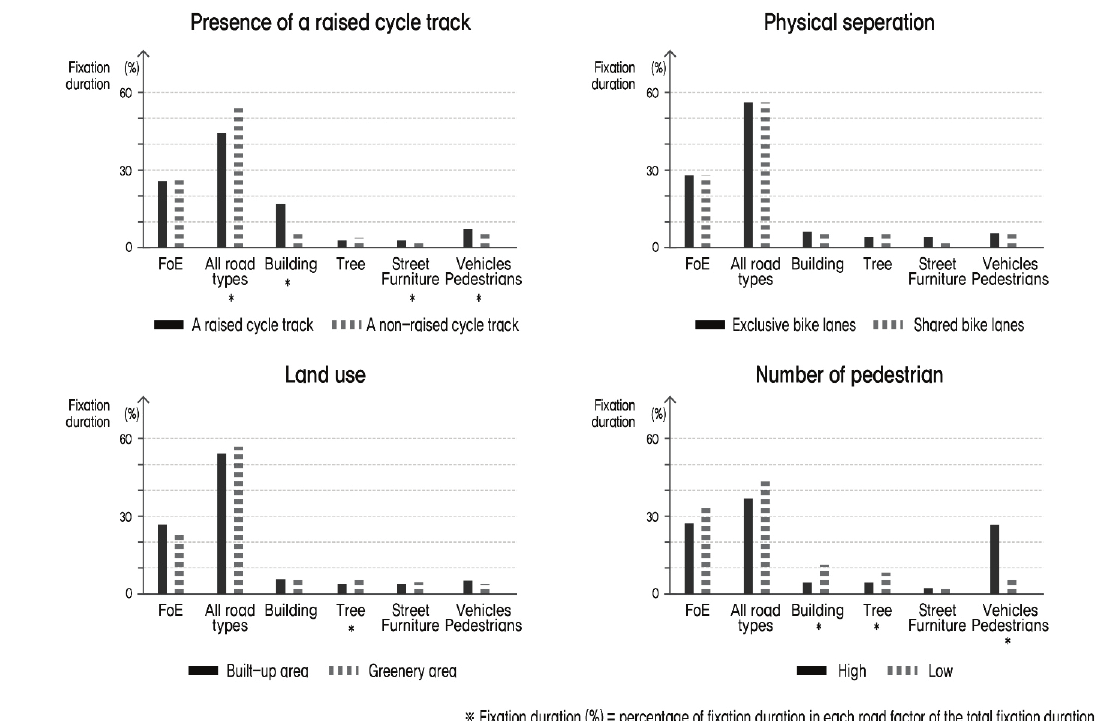
Figure 8. Mean fixation duration percentage (%) in FoE, all road types, buildings, trees, street objects, vehicles, & pedestrians. And * presents to have significant